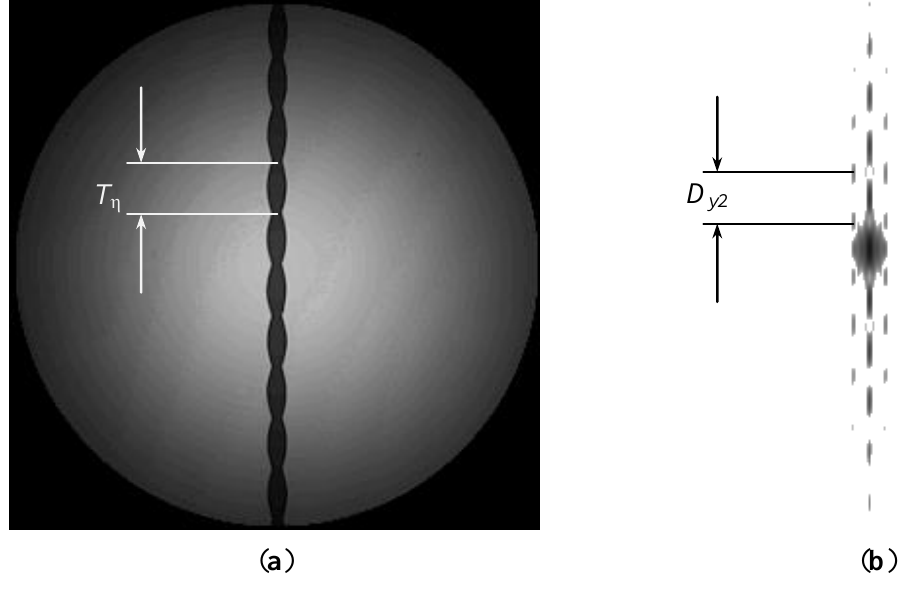
Figure 3. ( a ) The digital image of the twisted yarn of two singles; ( b ) Its diffraction pattern after two transforms. Between Fourier transforms we have built the image using Equation